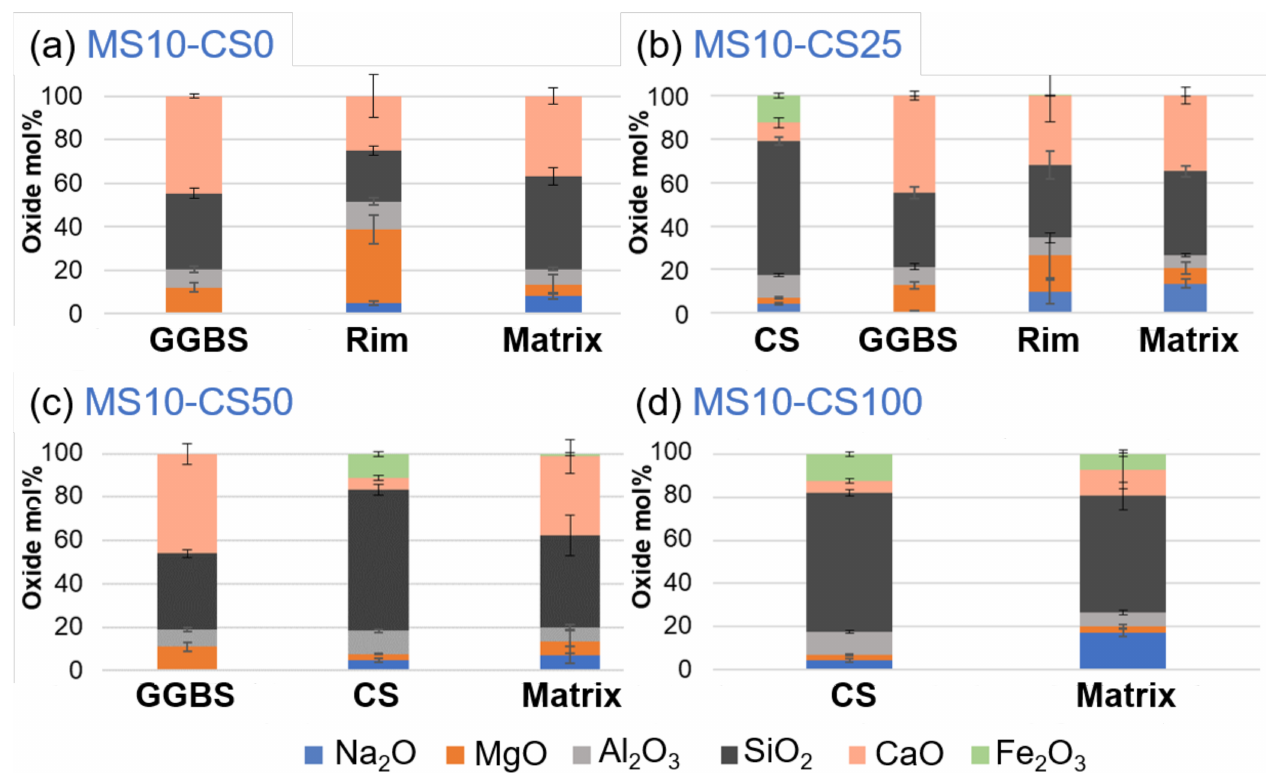
Figure 13. EDS-SEM of 10 wt% metasilicate systems. Slag composition varies from ( a ) 10 wt% GGBS, 75 wt% GGBS, ( b ) 25 wt% CS, 50 wt% GGBS, ( c ) 50 wt% CS to ( d ) 100 wt% CS (see Table 2 for mix